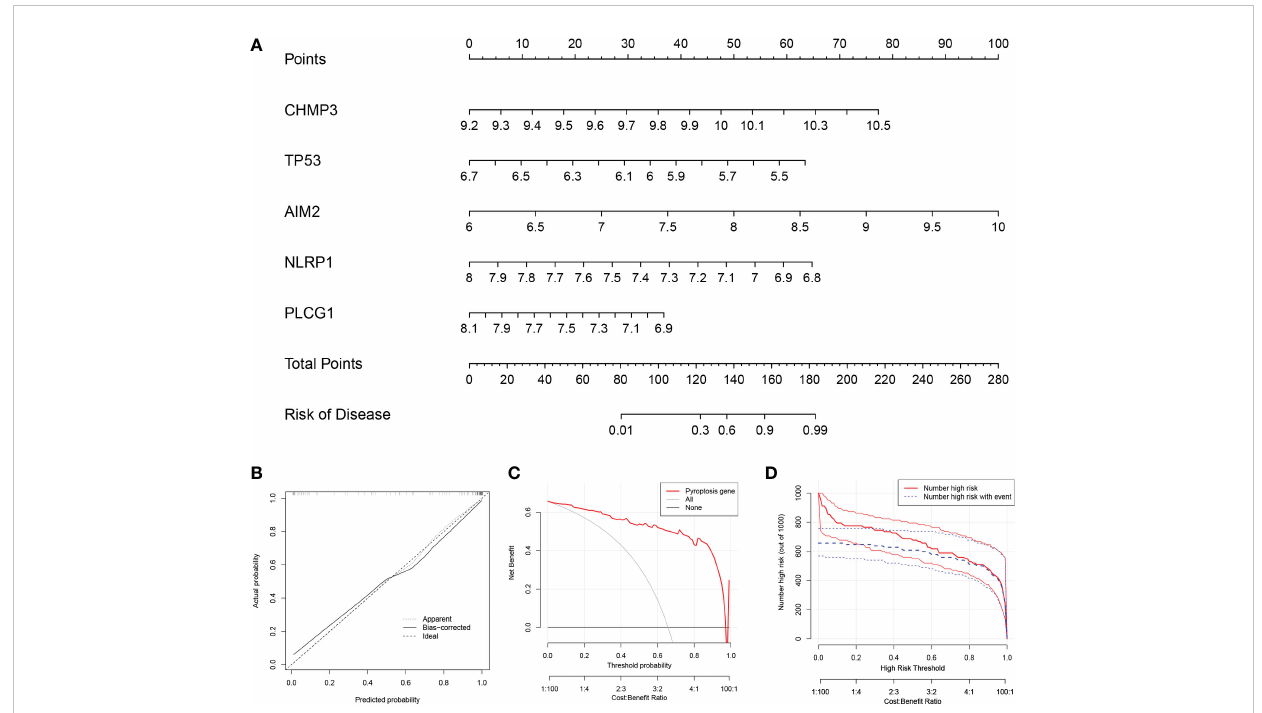
FIGURE 2 Construction of the nomogram model. (A) Construction of the nomogram model based on the 5 PRGs. (B) Predictive robustness of the nomogram model as revealed by the calibration curve. (C) Decisions based on the nomogram model may bene fi t RA patients. (D) Clinical impact of the nomogram model as assessed by the clinical impact